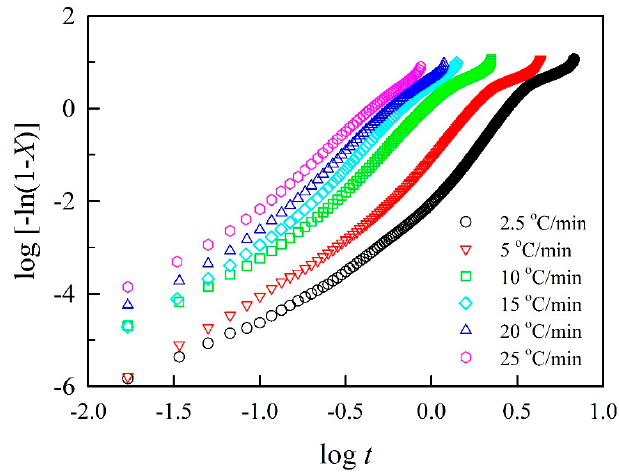
Figure 2. Avrami plots of log[ − ln(1 − X )] versus log t for polypropylene with unmodified bamboo fibers. Table 3. Parameters calculated at various cooling rates based on the Avrami model. Cooling Rate (°C/min)